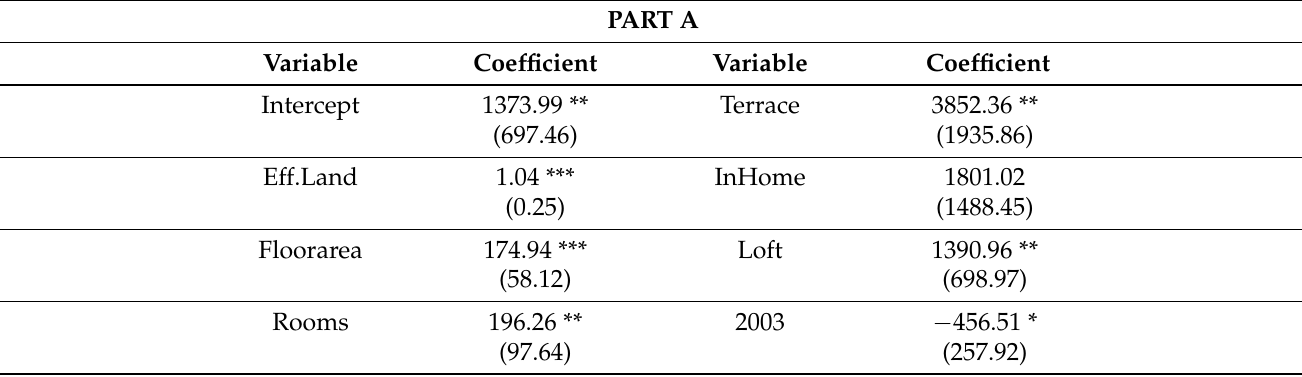
Table 1. Estimation results of hedonic regression with interaction terms. (This table shows the regression results for the model of relative implicit rents according to Equation(13) in two parts. Besides the hedonic rental prices for different apartment characteristics as well as yearly dummies in Part A, the implicit relative land prices for regions 1 to K in the canton of Zurich are given in Part B. These coefficients are reflected by interaction terms ( reg _ id ) calculated by region dummies ( ID ) times the ef ficient land size ( ef f _ land ) . Due to the small number of observations in some municipalities, only 128 out of 171 regions are included (43,684 rental observations). The estimation’s R 2 amounts to 0.786. Heteroscedasticity-robust standard errors are shown in parentheses for hedonics and yearly dummies. ***, **, and * denote statistical significance at the 1, 5, and 10% levels,